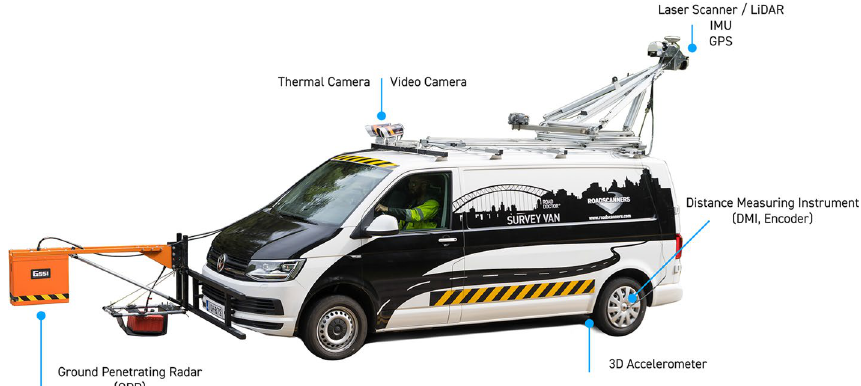
Fig. 4 An example of a road scanning vehicle. This image is retrieved on May 15, 2022 from https://www.